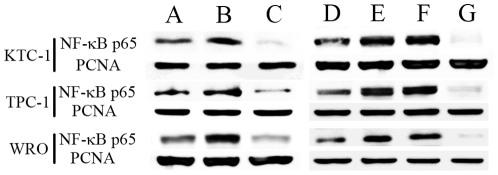
NF-κB protein level changes by different therapies.DTC cells were left untreated as controls (A), or treated with 20 MBq/ml 131I (B) or in combination with 5 µmol/L Bay 11-7082 (C) for 6 hours. Then nuclear protein extracts were examined for NF-κB p65 by Western blot. In the second set of experiments, control cells were left untreated (D). After no oligonucleotide (E), scrambled oligonucleotides (F) or p65 siRNA (G) transfection, DTC cells were treated with 131I (20 MBq/ml) for 6 hours. Then nuclear protein levels of NF-κB p65 were analyzed. PCNA was used as a loading control for nuclear proteins. Similar results were obtained in three independent experiments.